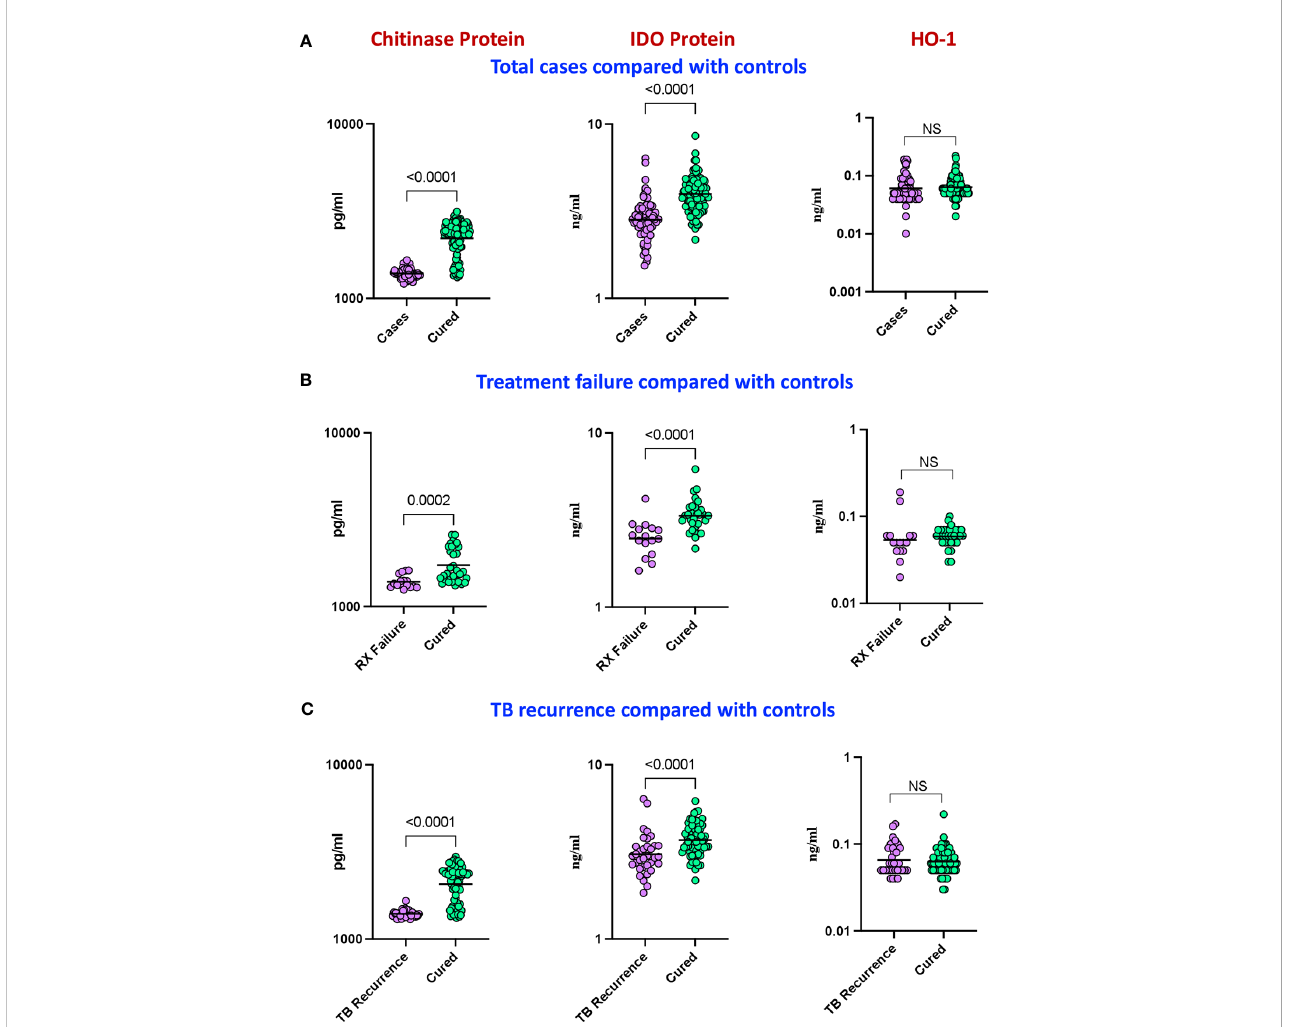
FIGURE 2 Baseline analysis of plasma levels of chitinase protein and IDO protein in cases. The baseline plasma levels of chitinase protein, IDO protein and HO-1 were measured in (A) cases (n=68) and controls (n=108) (B) TB treatment failure (n=16) and controls (n=35) and (C) TB recurrence (n=34) and controls (n=69). The data are represented as scatter plots with each circle representing a single individual. P values were calculated using the Mann-Whitney U test with Holm ’ s correction for multiple comparisons. NS : No signi fi cance